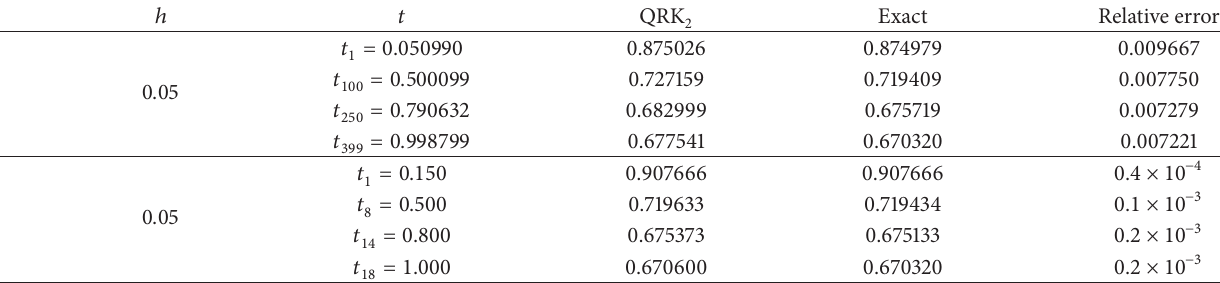
method with the exact values and its relative 2